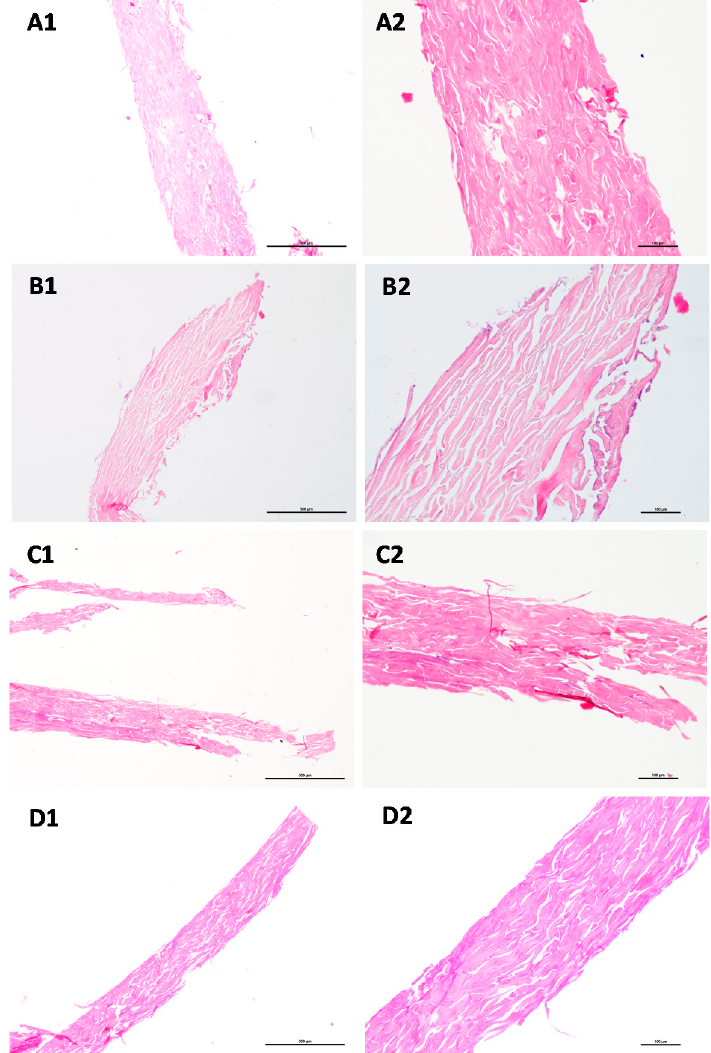
Figure 3. Histological appearance of SC after exposure to different isolation conditions (( A – D ), ac- cording to the designations defined in Table 1). HE staining; Scale: A1 – D1 (4×), bar 500 µm; A2 – D2 according to the designations defined in Table 1). HE staining; Scale: ( A1 – D1 ) (4 × ), bar 500 µ m; (10×), bar 100 µm. ( A2 – D2 ) (10 × ), bar 100 µ